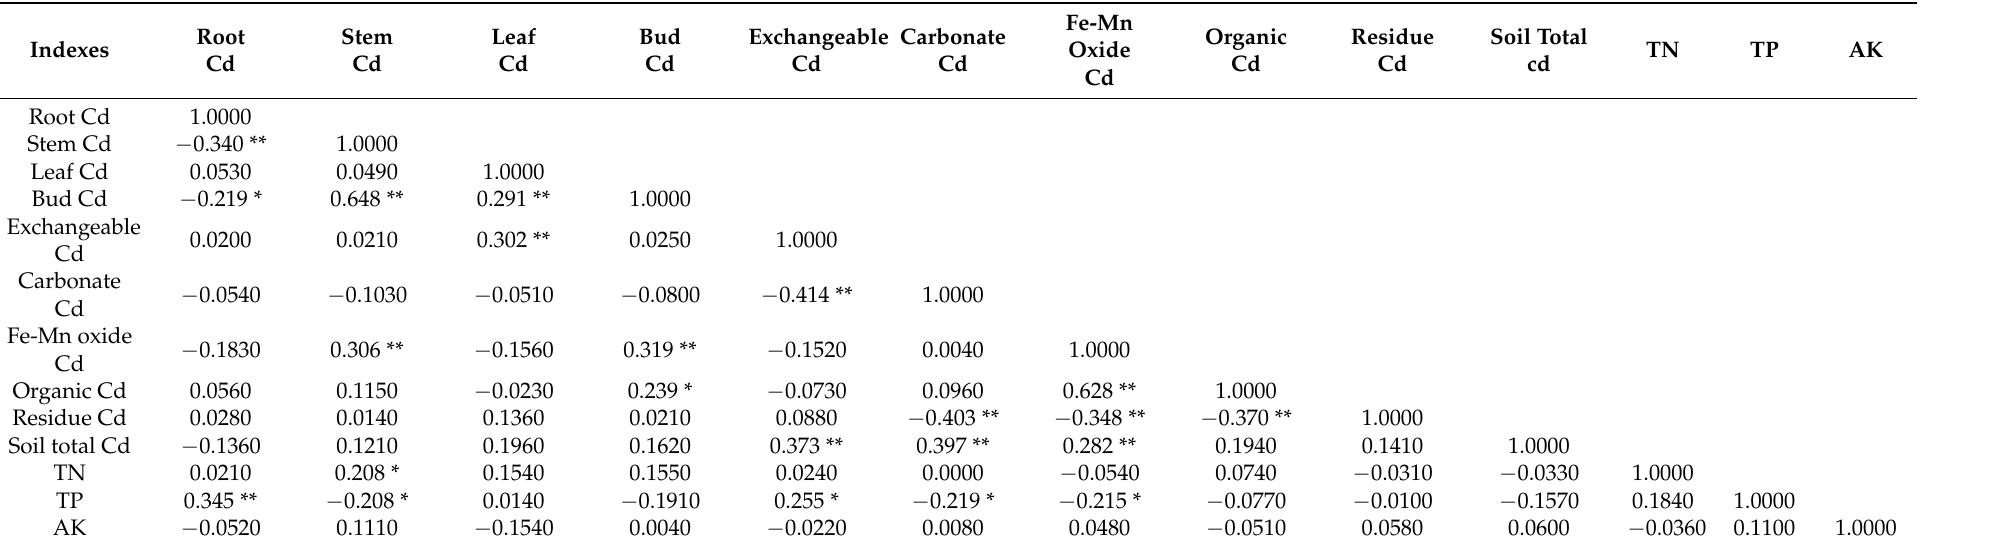
Table 2. The correlation coefficients between soil Cd, soil NPK, and plant